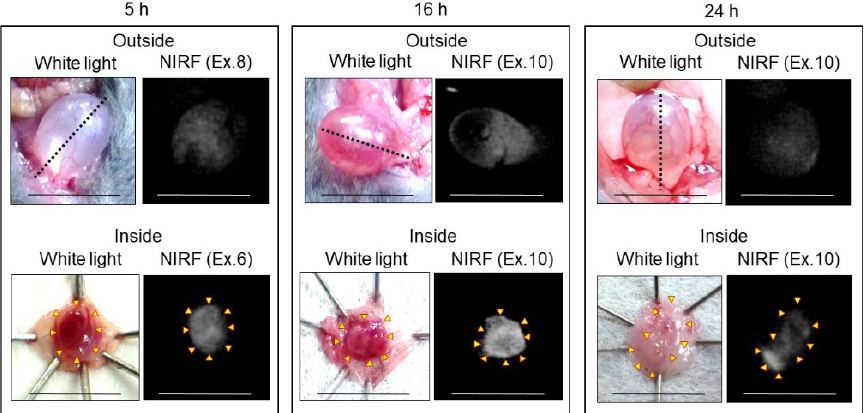
Figure 11. Representative near-infrared fluorescence (NIRF) imaging of MB49 cancerous bladders in three mice after intravenous administration of ASP5354. ASP5354 (240 nmol/kg body weight) was intravenously injected, 5 h (after rinsing with saline 5 times), 16 h (without rinsing), and 24 h (without rinsing) after injection, NIRF imaging was performed from outside the bladder. After imaging, the bladder was picked out and opened along the black dotted line. NIRF in the obtained bladder inner layer was imaged. Excitation levels (Ex.) are shown above photos. NIRF is displayed in white. Scale bar represents 10 mm. Yellow arrows show points of boundary between NIRF and